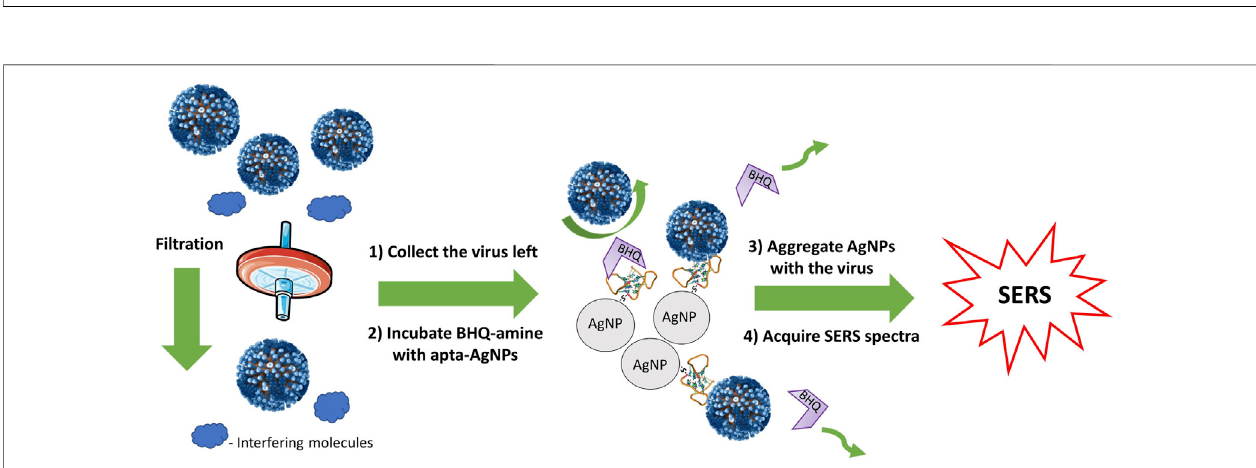
FIGURE 10 | Schematic representation of the proposed sensor. Small objects are fi ltered out, and large objects displace the BHQ-2 amine from the complex with the aptamer decreasing the SERS signal in the probe.